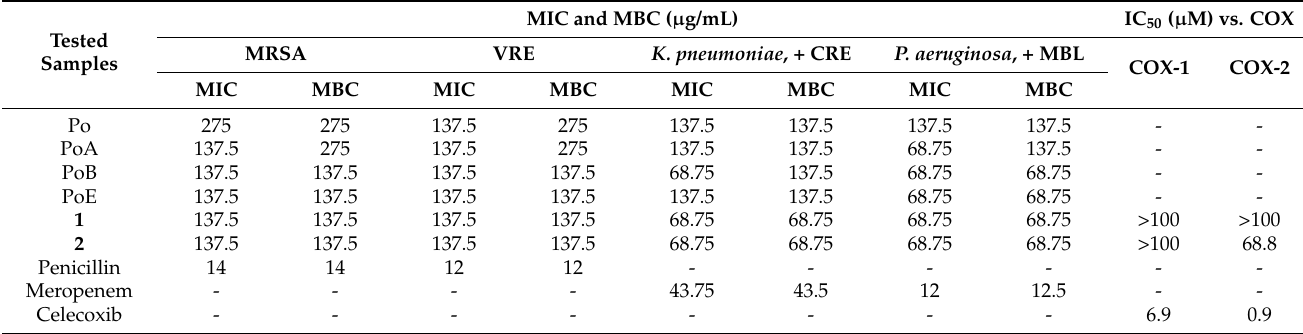
Table 1. Minimum inhibitory concentrations (MIC) & minimum bactericidal concentrations (MBC) against multidrug-resistant bacterial isolates, and cyclooxygenase (COX) inhibitory activity of P. ophthalmicus extracts and alkaloids 1 and 2 . Tested